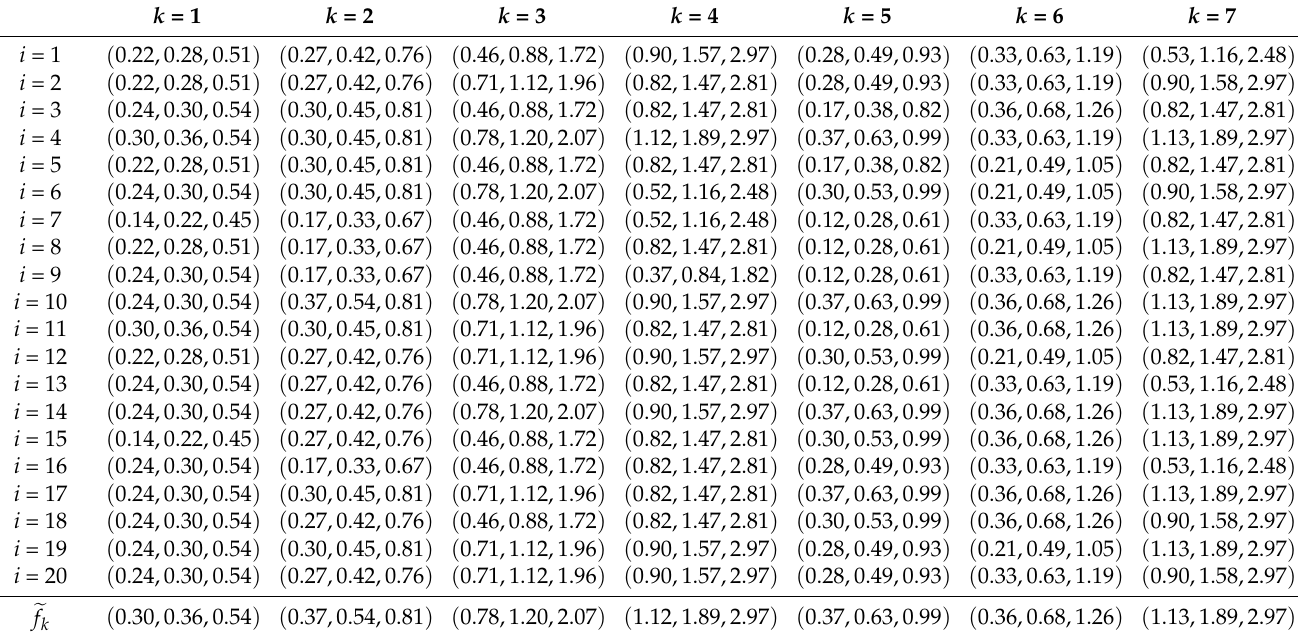
Table 5. The weighted fuzzy decision matrix and reference